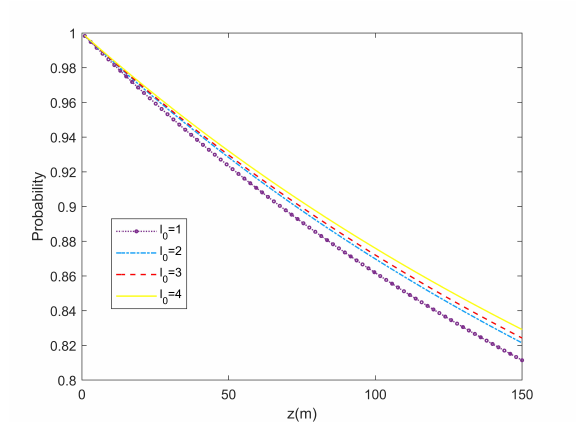
Figure 1. Received probability of the OAM signal modes of DARR beam versus propagate distance Z for different OAM mode l 0 .